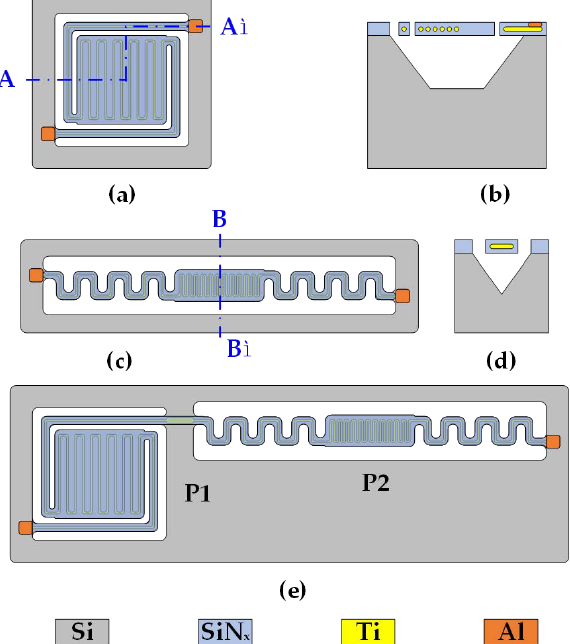
Figure 2. Designed structure of the Pirani gauge in this work. ( a ) Top structural view of P1; ( b ) A-A’ cross-sectional view of P1; ( c ) Top structural view of P2; ( d ) B-B’ cross-sectional view of P2; ( e )Top structural view of composite-type MEMS Pirani